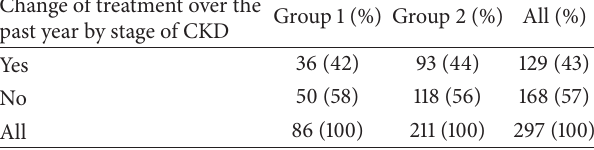
Table 5: GP’s optimal solution to meet glycaemic control objectives. GP’s optimal solution to meet glycaemic control